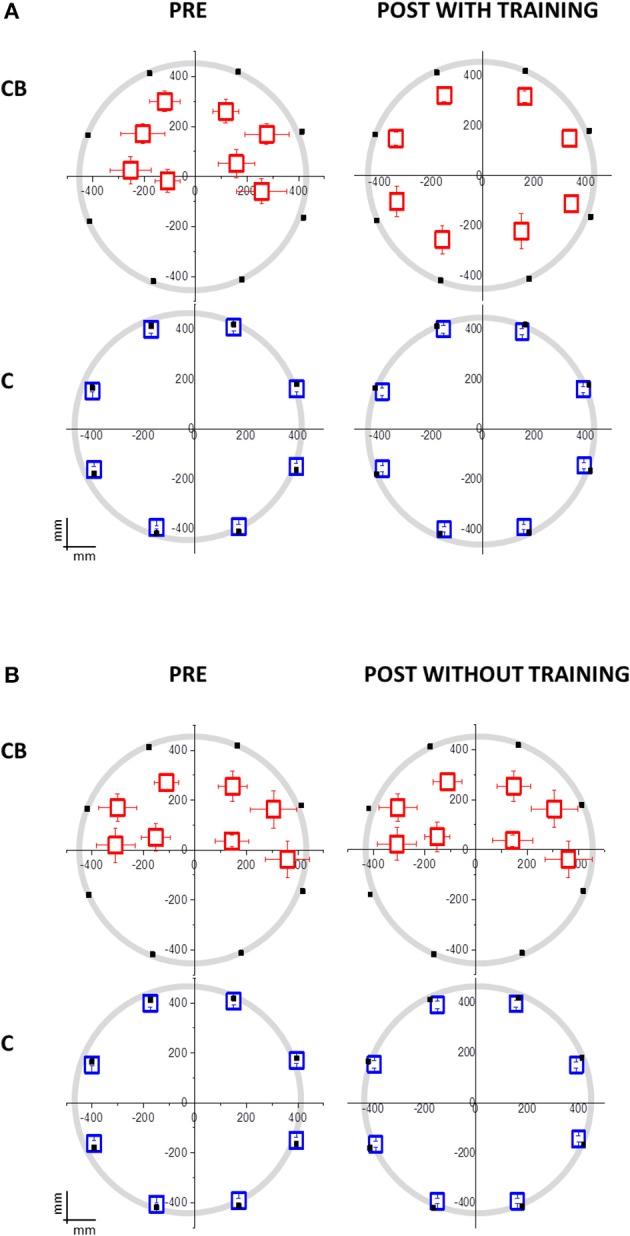
Mean localization bias in congenital blind individuals (CB) and sighted blindfolded controls (C) relative to the hand pointing task following the moving sound from the origin to one of the eight position on the circle. The black dots indicate the 8 possible end-point positions. The origin (0,0) corresponds to the nose of the participant. (A) Group that performed the audio-motor training (CB: N = 10; 7 females; mean age = 39 ± 12 years old; C: N = 14; 7 females; mean age = 35 ± 15 years old). The deficit in the lower side positions isn't present in CB after the training. No significant change is present in C. (B) Group that did not perform the audio-motor training (CB: N = 10; 6 females; mean age = 45 ± 12 years old; C: N = 14; 7 females; mean age = 44 ± 13 years old). The deficit in the lower side positions is maintained in CB after the inter-session without training. No difference is present in C, between pre and post-session, and between training group.